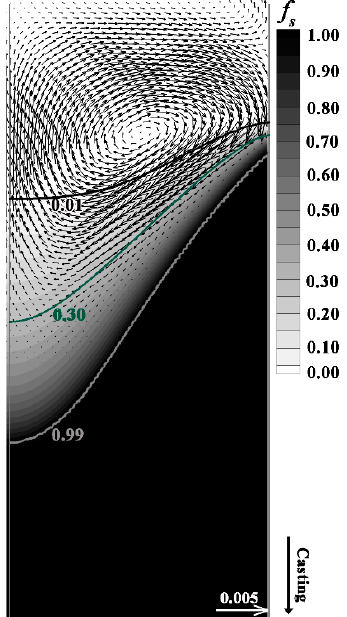
Figure 7. Simulated solid fraction and vector plot of the relative velocity (v-v cast ) in DC casting. The simulated distribution of the free-floating grains (represented by the particles with a diameter of 100 μ m) in a solidifying DC casting is presented in Figure 8 for different calculation times.